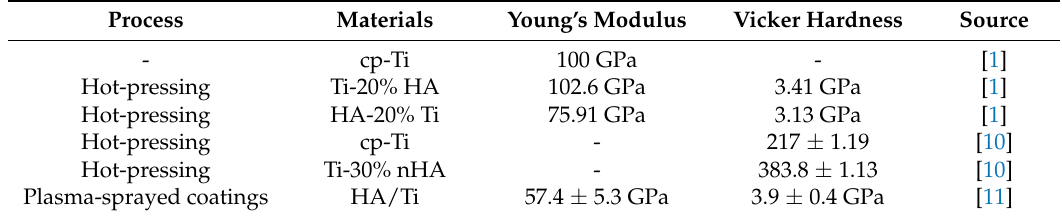
Table 1. Comparison of the mechanical properties of Titanium and Titanium/HA